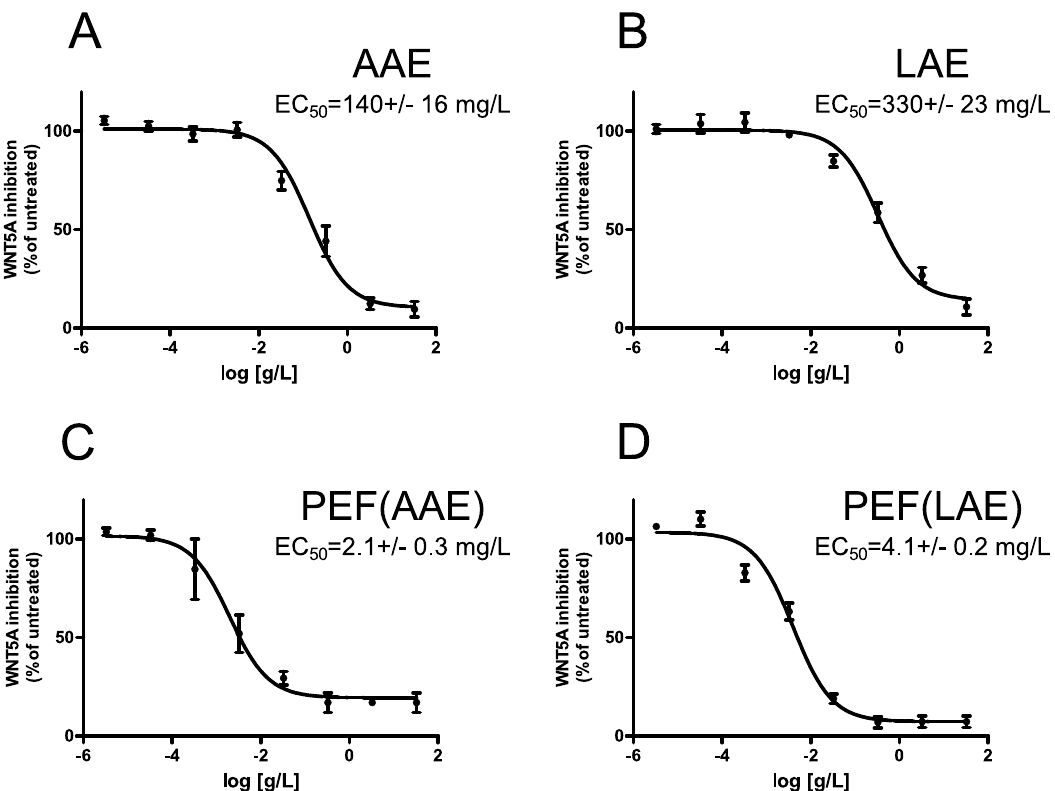
Figure 1. AAE and LAE act as WNT pathway inhibitors. ( A , B ) Dose-response curves represent AAE ( A ) and LAE ( B ) modulation of WNT/ β -catenin pathway in HEK293 cells co-expressing FZD4 and the WNT reporter construct (TCF-wt GFP). Values indicate changes in GFP expression (expressed as mean percentage change over untreated samples). ( C , D ) Dose-response curves represent PEF(AAE) ( C ) and PEF(LAE) ( D ) modulation of WNT/ β -catenin pathway. Values are reported as mean ± SD ( n = 3 replicates). EC 50 values for each sample are shown on the corresponding graph and are reported as mean ± SEM ( n = 5 independent